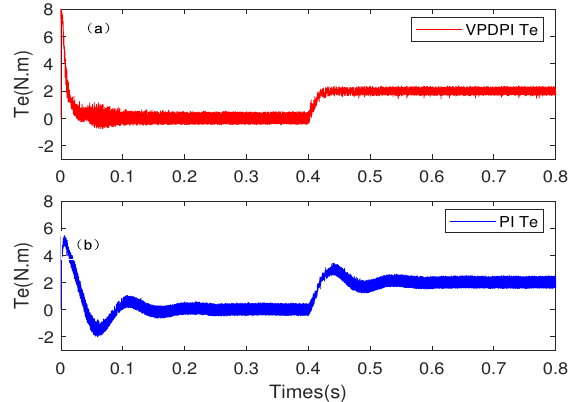
Figure 17. Torque response process under two control methods. ( a ) Torque response under the proposed VPDPI control. ( b ) Torque response under the PI control